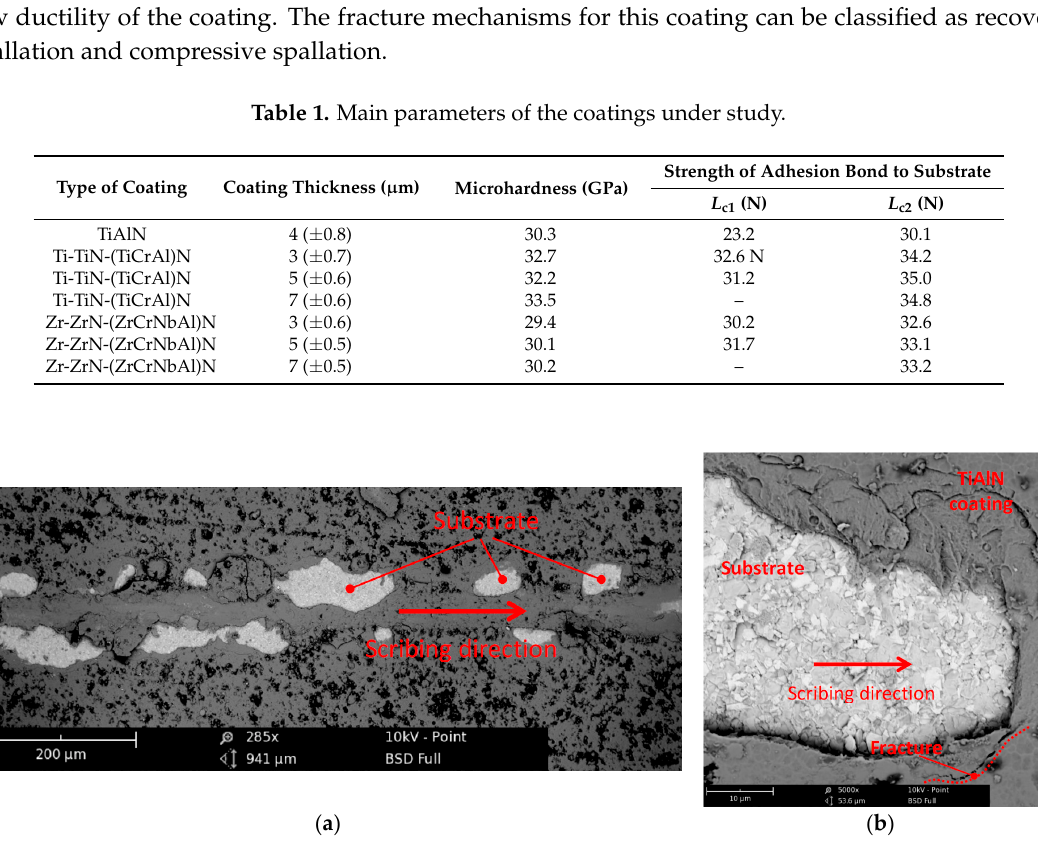
Figure 1. Fracture pattern for monolayered coating TiAlN in scratch testing: ( a ) General view of scribing groove in area of L c1 –L c2 ; ( b ) Area of coating spallation from substrate.